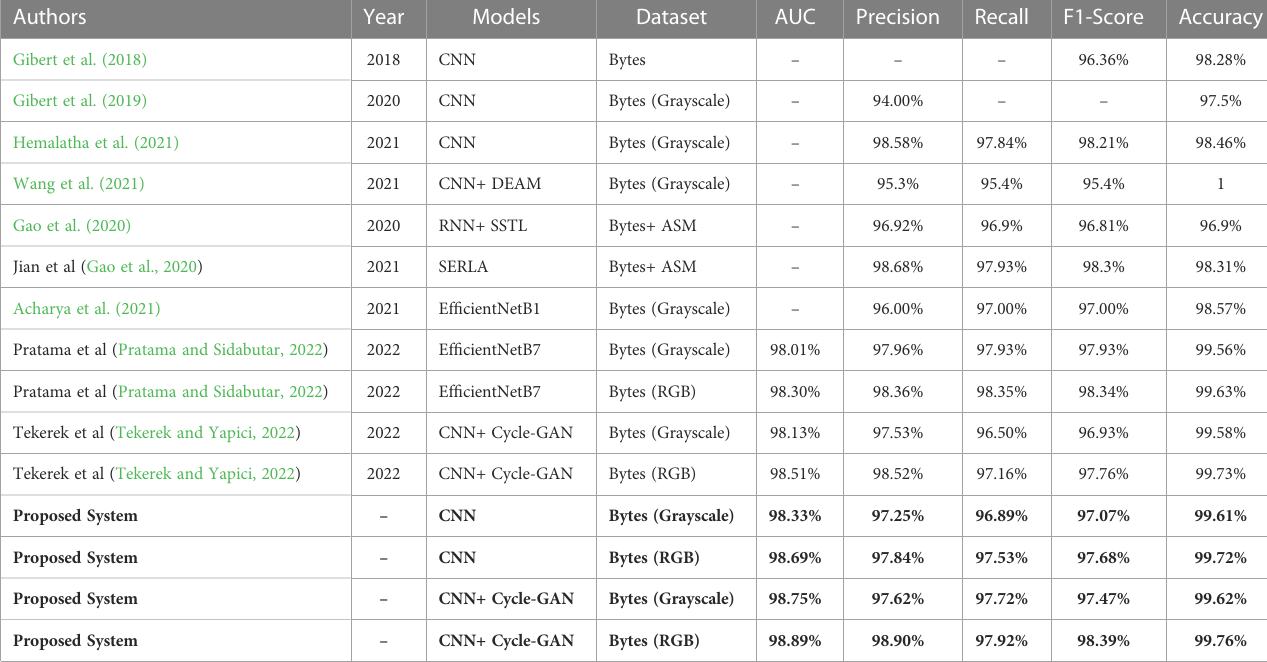
TABLE 5 Comparison of the proposed system to systems in the literature using the BIG2015 dataset. Authors